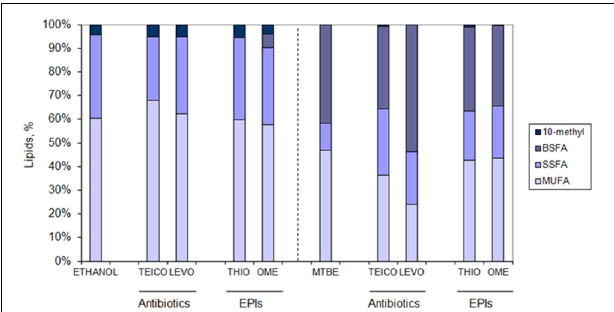
FIGURE 6 | Lipid composition of M. vaccae cells adapted to ethanol (Left) and MTBE (Right) and exposed to 1 / 2 MIC of the antibiotics teicoplanin (TEICO) and levofloxacin (LEVO) and to 1 / 2 MIC of the efflux pump inhibitors (EPIs) thioridazine (THIO) and omeprazole (OME) after 41 h of cell growth (mid-exponential phase). Fatty acid class abbreviation as in Figure 5